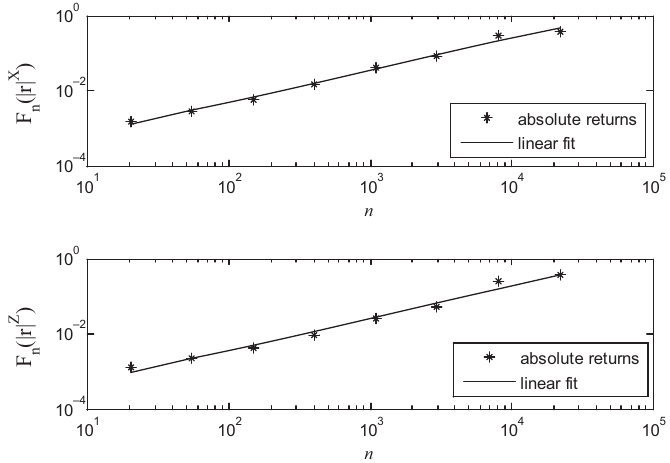
Figure 8. Estimation of self- similarity